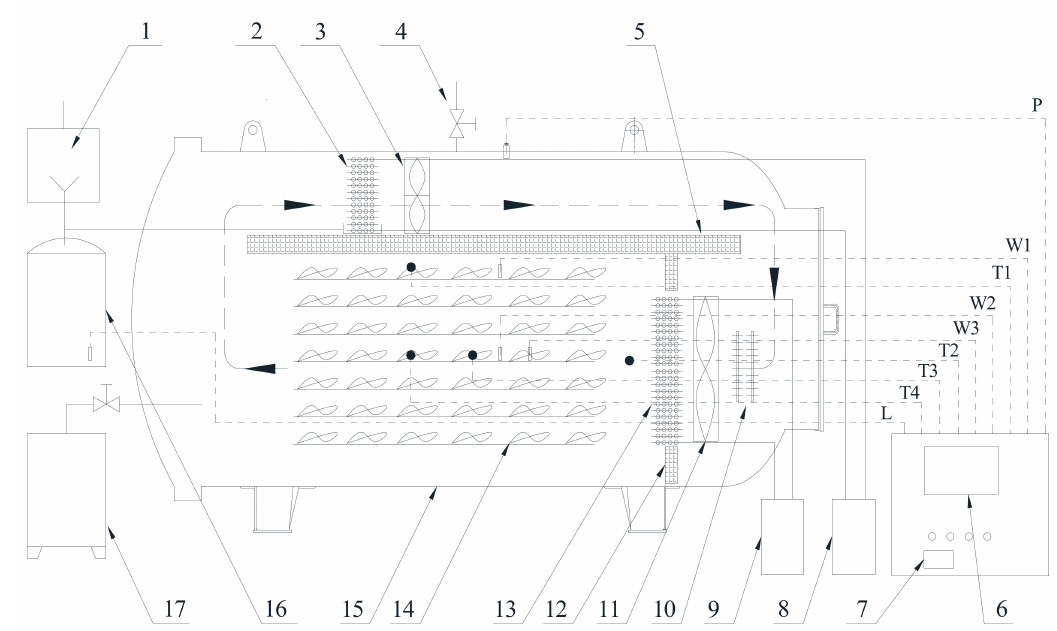
Figure 1. Schematic diagram of the drying system, with combined LPSSD and HPD. 1. Vacuum